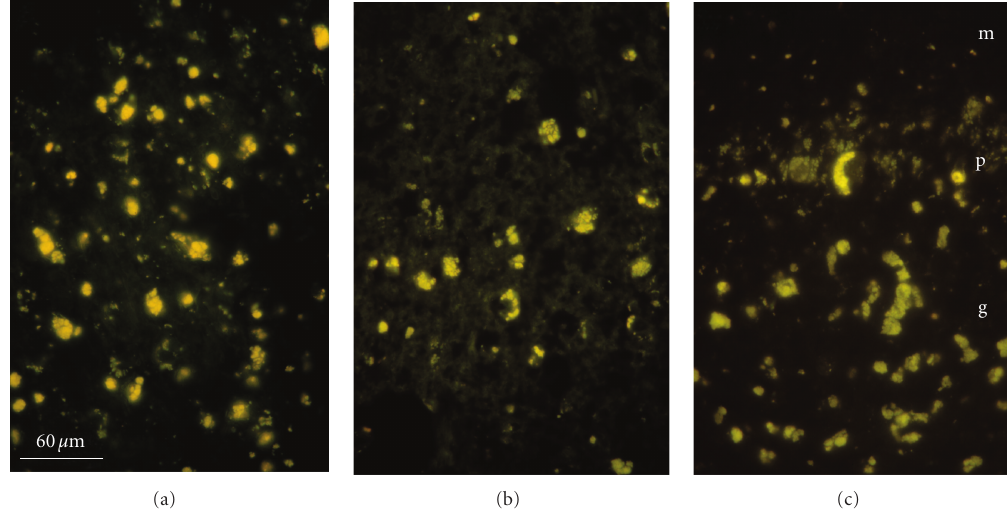
Figure 1: Fluorescence micrographs of the ganglion cell layer of the retina (a), cerebral cortex (b), and cerebellum (c) from the Australian Shepherd that was euthanized after exhibiting the neurological signs described in the text. In the cerebellum, autofluorescent material was most prominent in the Purkinje cell (p) and granular layers (g), with lesser accumulation in the molecular layer (m). Bar in (a) indicates magnification of all 3 micrographs.